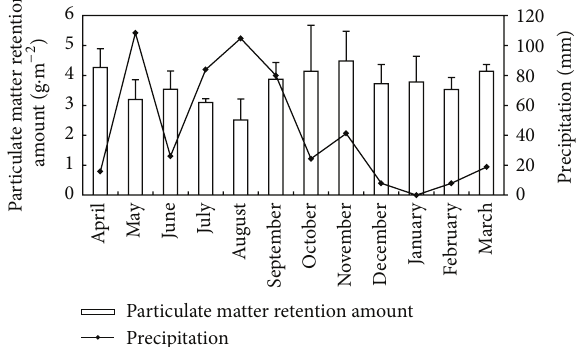
Figure4:Comparisonofthetemporalvariationsofmonthlyrainfall totals (mm) and mean leaf accumulation PM amount (g ⋅ m −2 , data are mean ± SD) by leaves of L . lucidum